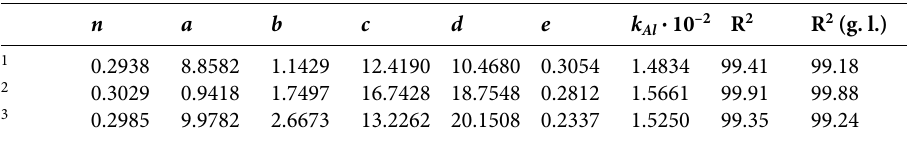
Table 4. CVT model constants by Eq. (45) and quality of fit